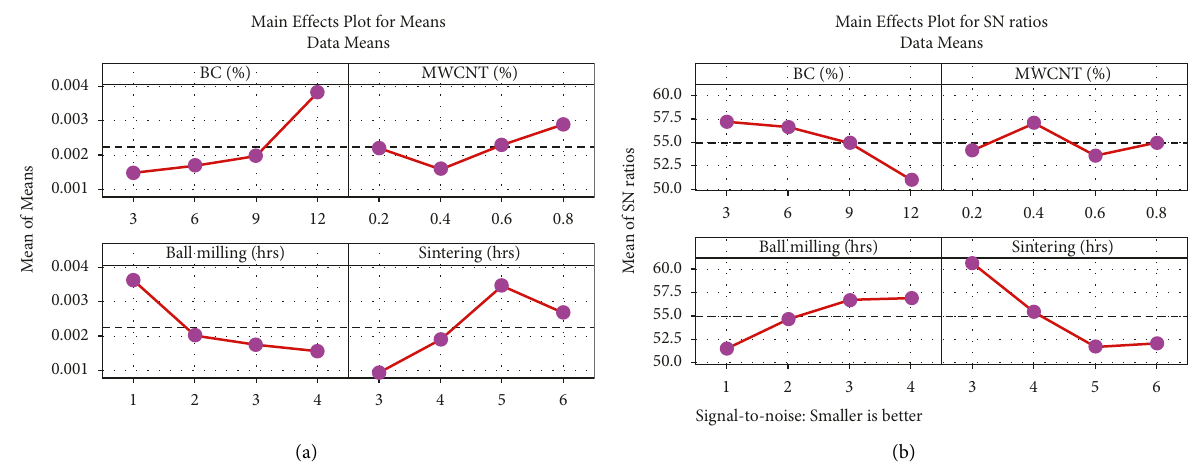
Figure 12: Main effects plot for corrosion analysis: (a) means (b) S/N ratio.